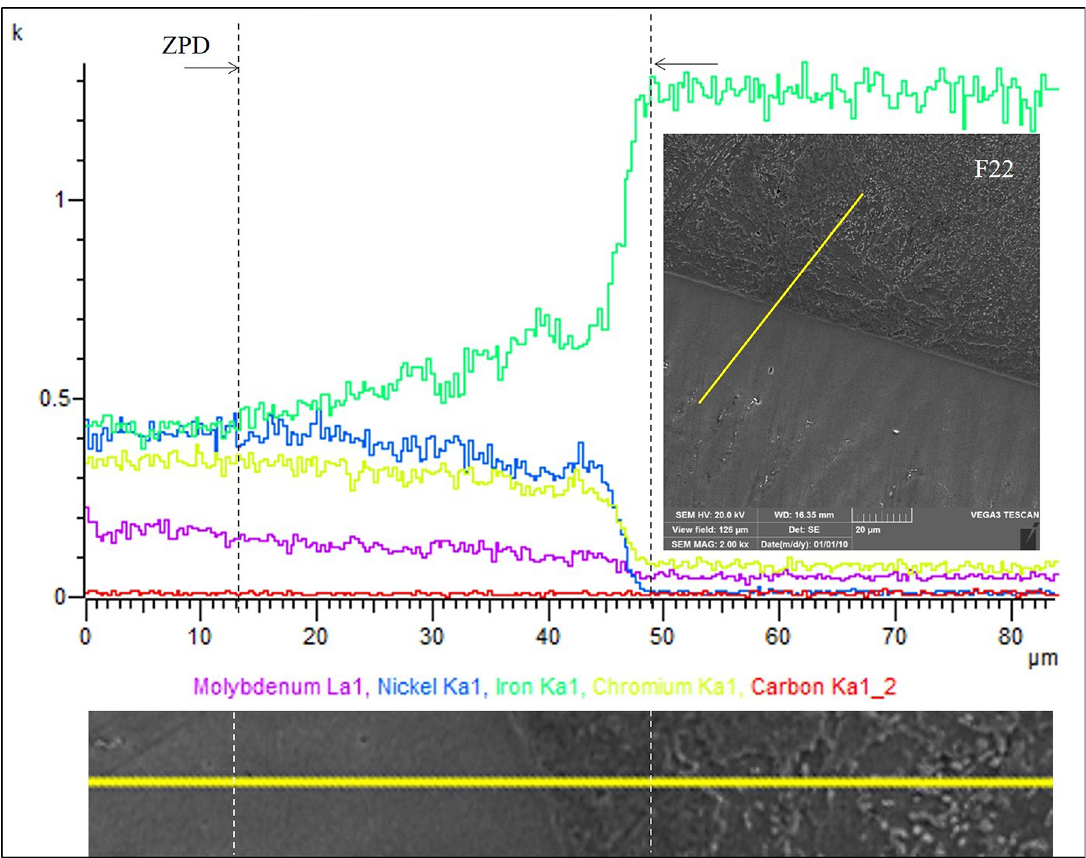
Figure 5. EDS, from the NCS, the butter weld interface